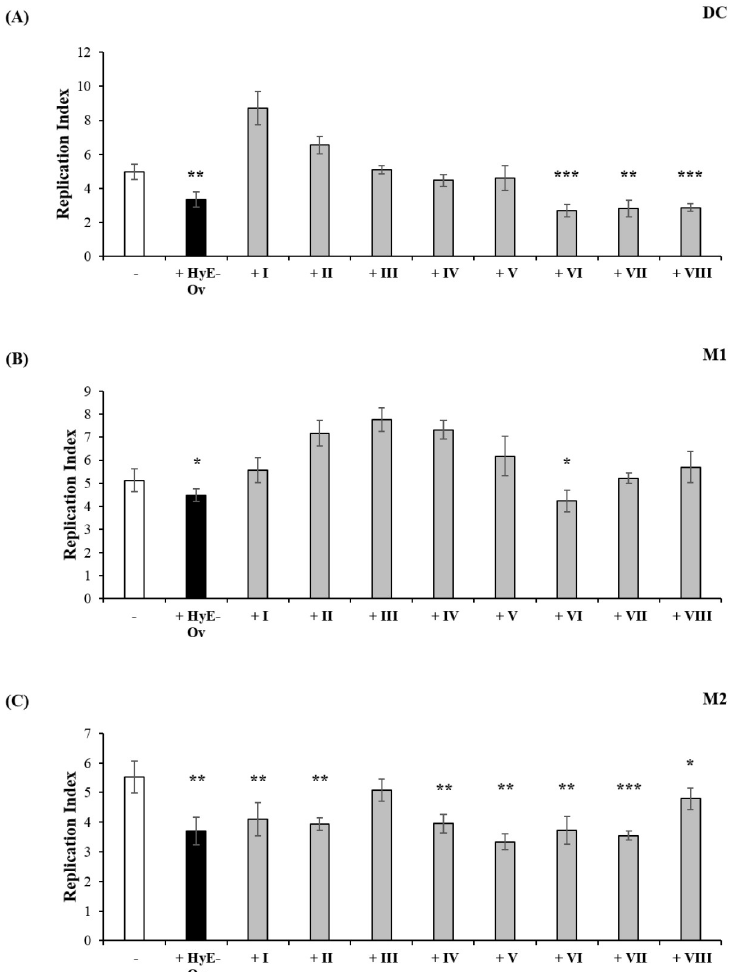
Fig 7. Effects of fractions from HyE-Ov on antimicrobial innate immune response. DC (A), M1 (B) and M2 (C) cells (5x10 5 /well) were infected with BCG-lux for 3 hours (MOI 5) and stimulated or not with HyE-Ov or with eight HyE-Ov derived fractions, used at the same concentrations present in the total extract. Mycobacterial growth was evaluated by luminometric analysis after 3 days from stimulation (t0). Data are shown as means ± SD of the ratio t3/t0 of RLU values from triplicate cultures and are representative of at least 2 independent experiments performed on cells from different donors. � p < 0.05, �� p < 0.01 and ��� p < 0.0001 in comparison with non-stimulated infected cells.